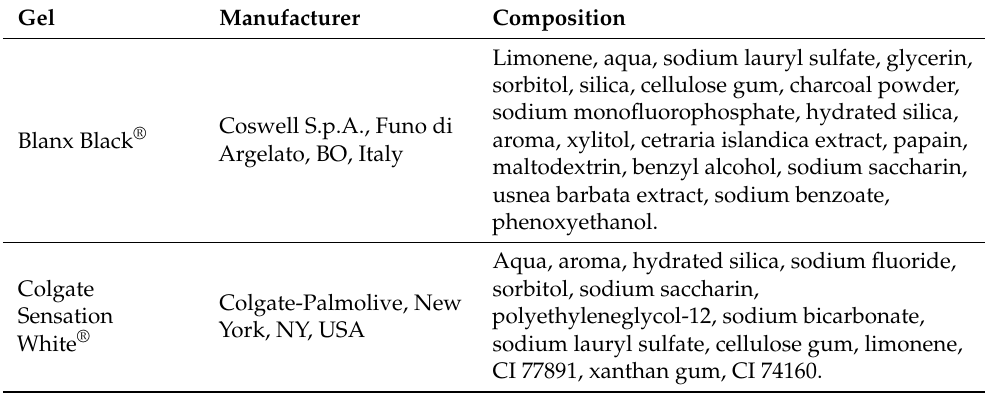
Table 2. Compositions of the tested